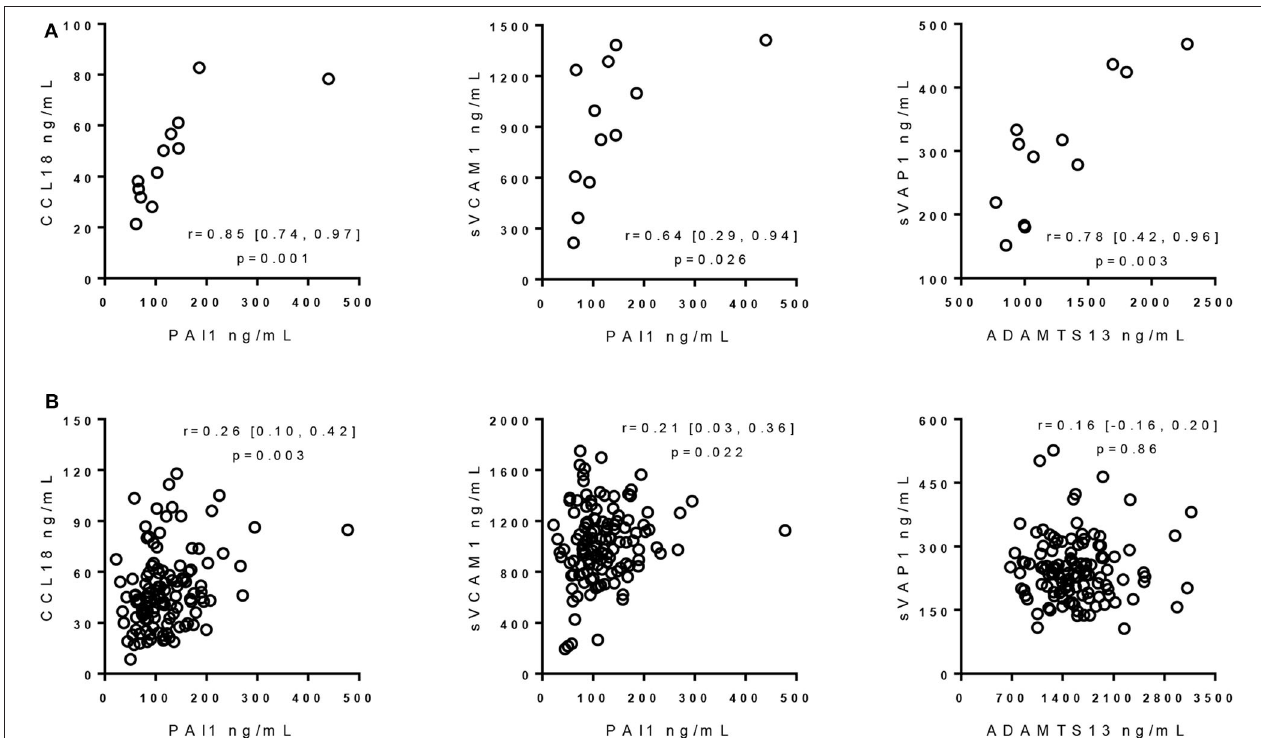
FIGURE 1 | Correlation of protein concentrations in multiple sclerosis patients with and without cerebral microbleeds. (A) Correlation of protein concentrations in MS patients with CMBs. Rho, 95% confidence intervals, and p -values from Pearson’s correlation with 1000-sample bootstrapping procedure, using logarithmic values of protein levels, are reported. (B) Correlation of protein concentrations in MS patients without CMBs. Rho, 95% confidence intervals, and p -values from partial correlation with 1000-sample bootstrapping procedure with age and sex as covariates, using logarithmic values of protein levels, are reported. ADAMTS13, a disintegrin-like and metalloprotease with thrombospondin type 1 motif 13; sVAP1, soluble vascular adhesion protein-1; PAI1, plasminogen activator inhibitor 1; CCL18, C-C motif ligand 18; sVCAM1, soluble vascular cell adhesion molecule